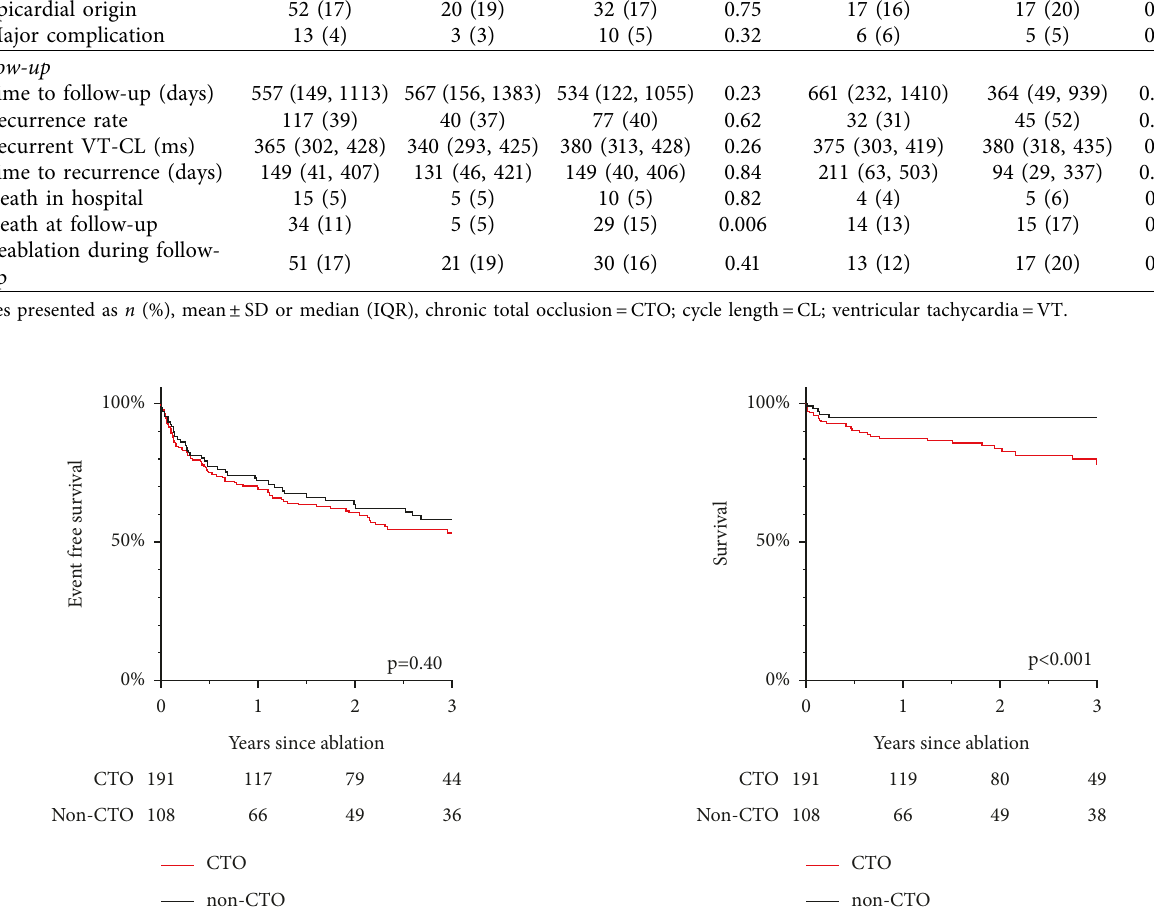
Figure 2: Recurrence of VT in chronic total occlusion (CTO) and non-CTO patients.